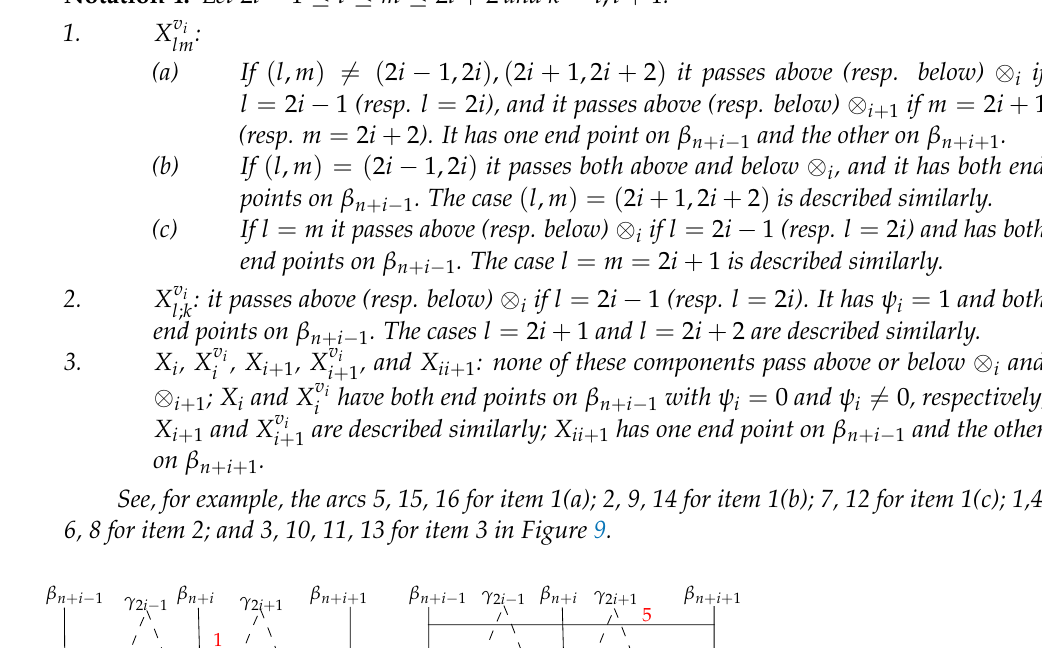
( 1,1;0,1 ) , 2 : X ( 0,1;0,1 ) 2 i 1; i −